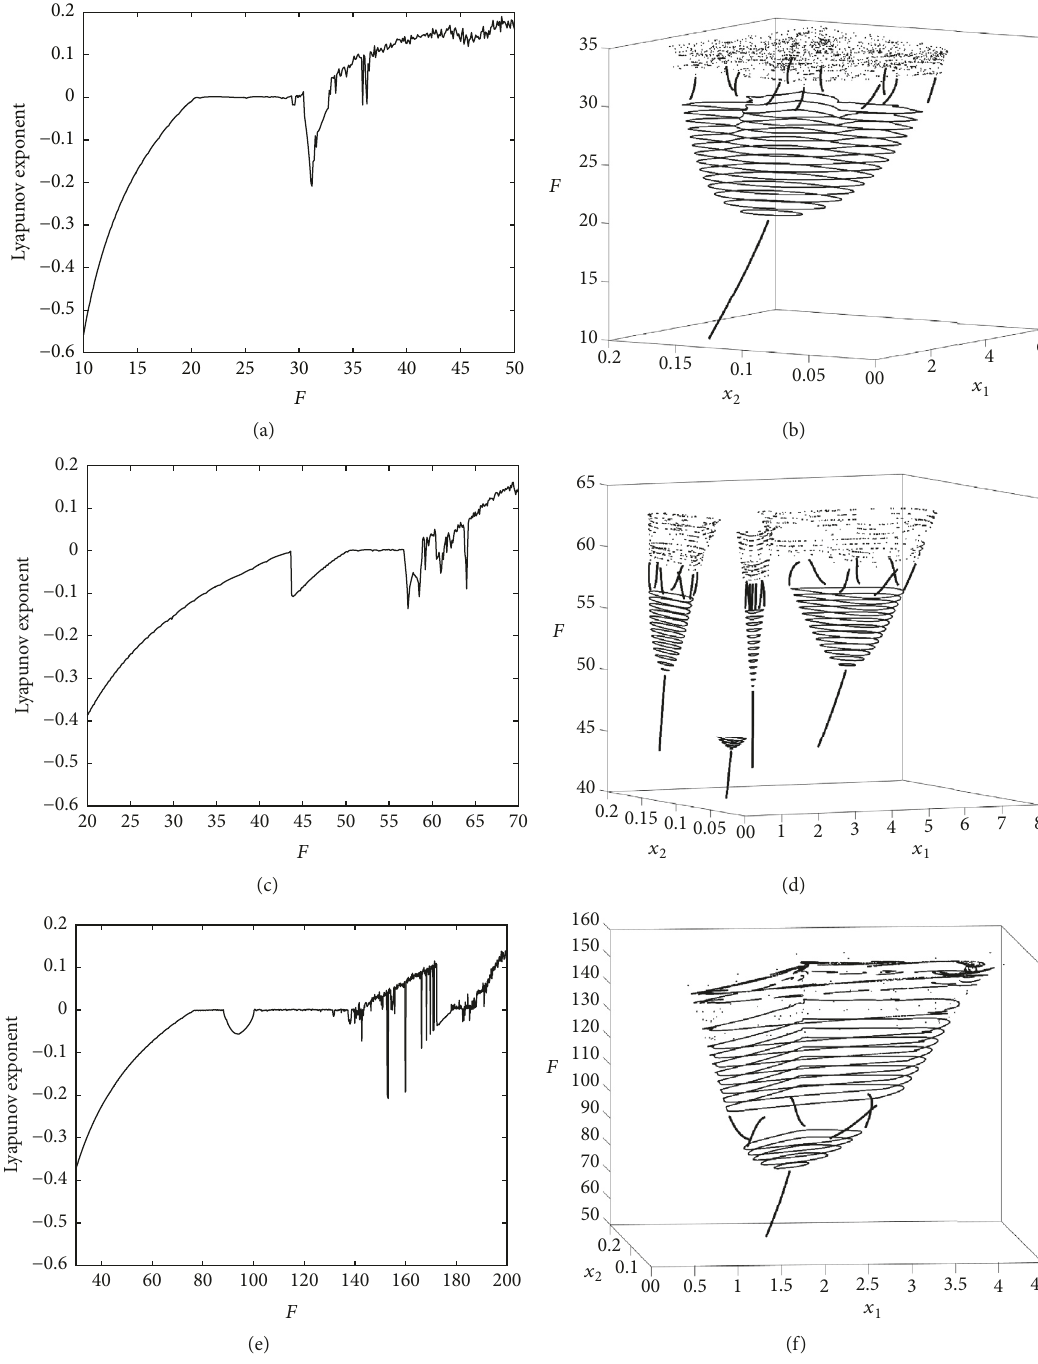
Figure 4: Values of Lyapunov exponents and the dynamics generated by (8) when 𝑃 = 0.5 . Parameter values: (a) and (b) (𝛼, 𝛽) = (0.1, 1.0) , (c) and (d) (𝛼, 𝛽) = (0.5, 1.0) , and (e) and (f) (𝛼,𝛽) = (0.8, 1.0) . ( 𝐿 < 0 corresponds to stable periodic orbits, 𝐿 = 0 corresponds to quasiperiodic orbits restricted to attracting invariant curves, and 𝐿 > 0 corresponds to chaotic